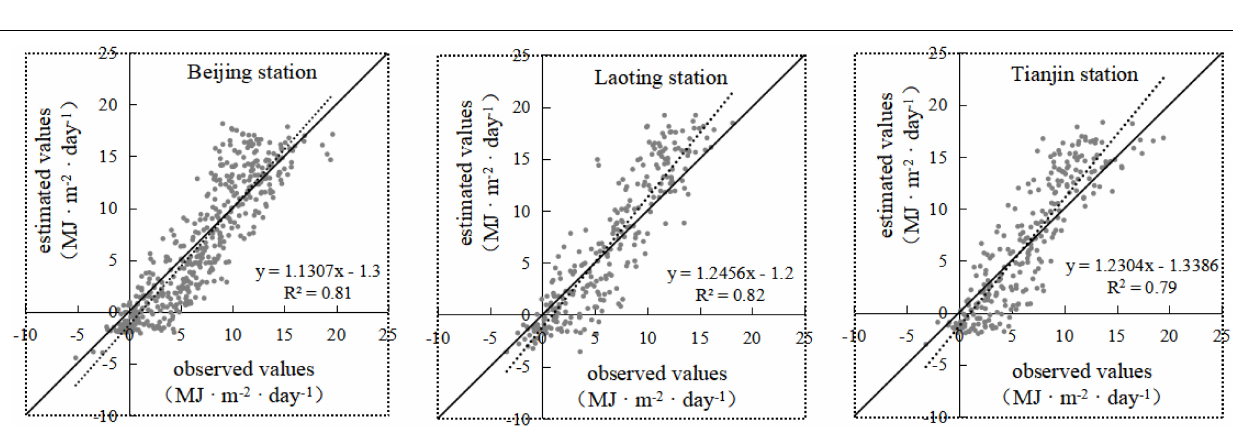
Frontiers in Ecology and Evolution |